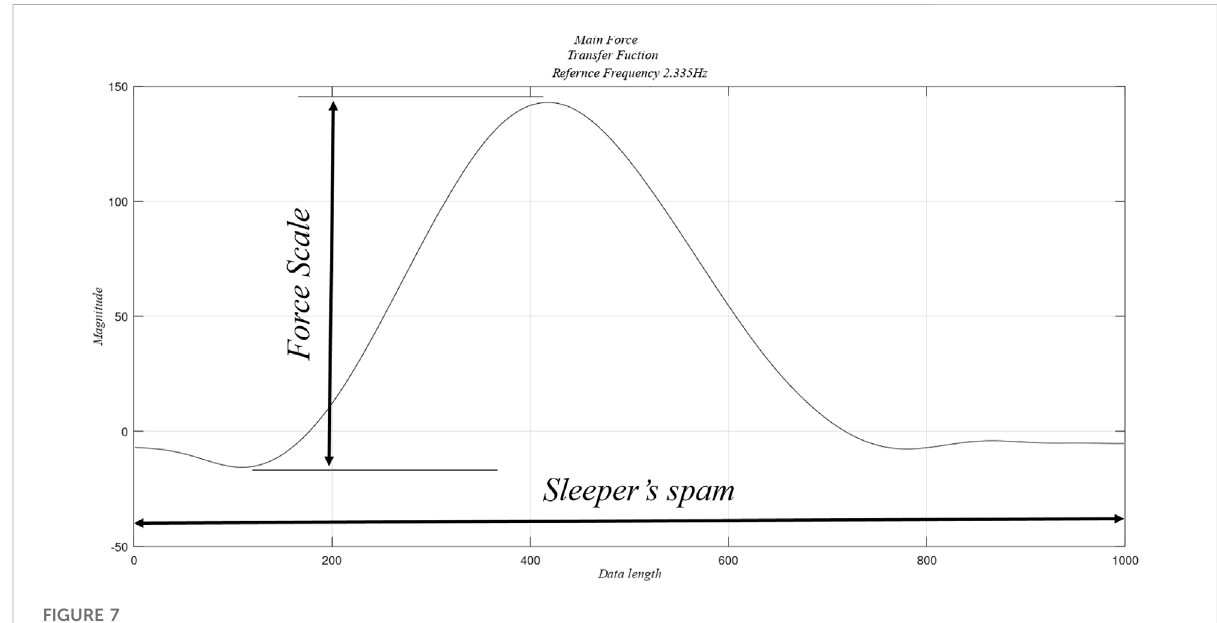
FIGURE 7 Base function for the deformation vector (cid:1) f